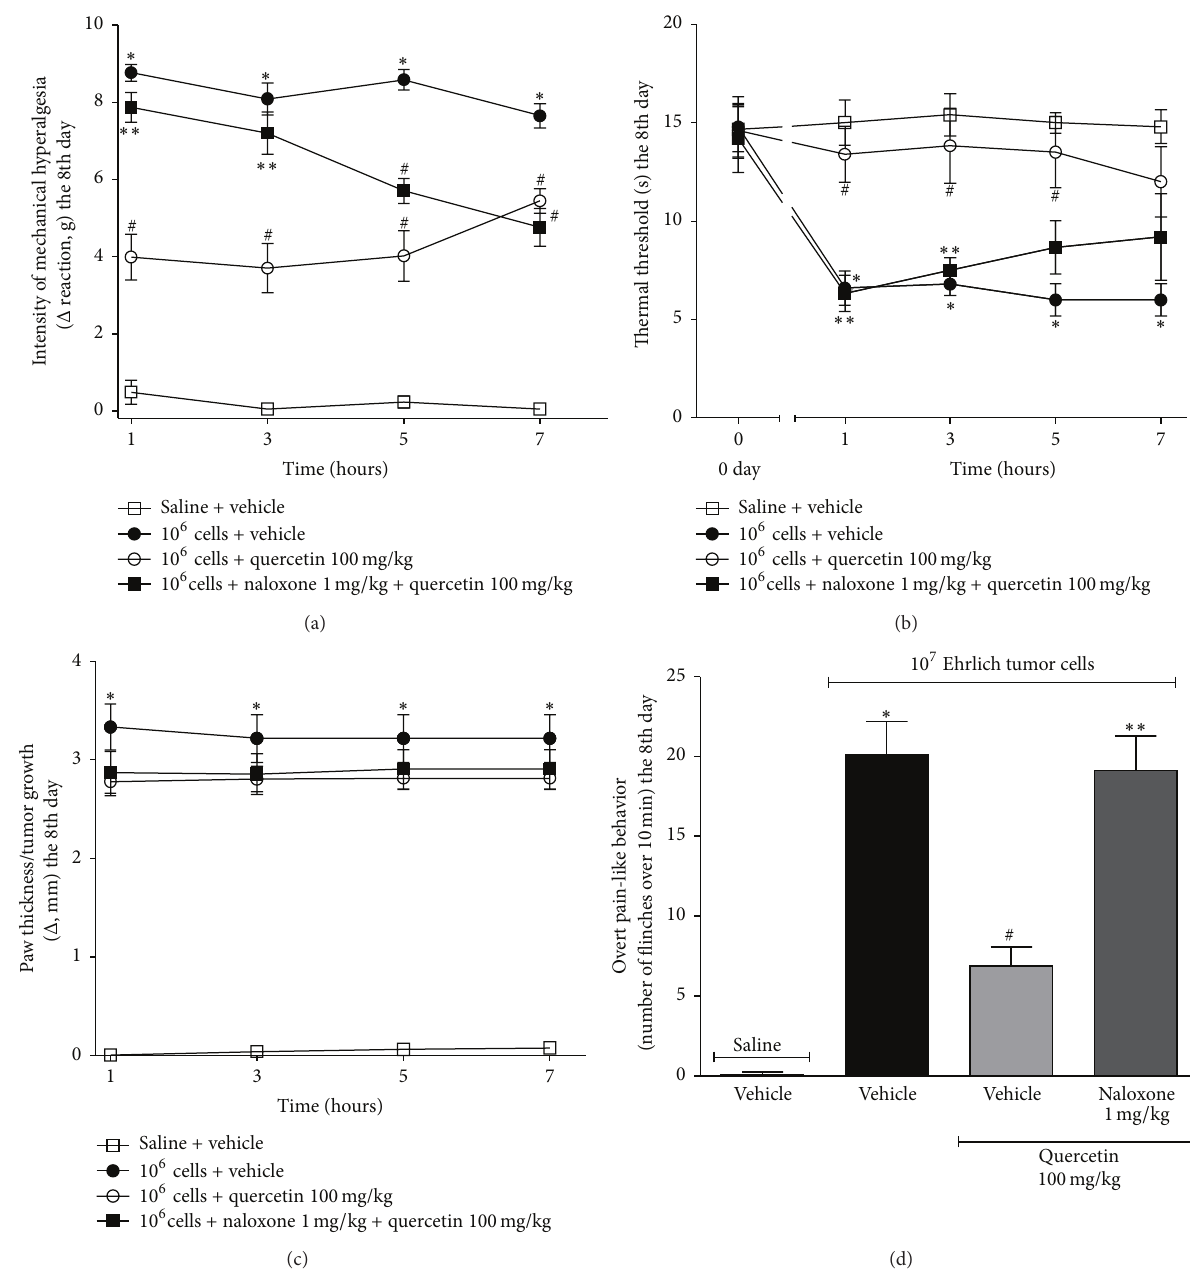
Figure 7: The opioid receptor antagonist, naloxone, inhibits quercetin analgesia in the Ehrlich tumor-induced pain model. Mice were treated with quercetin (100mg/kg, i.p., starting 10min after tumor administration) during 8 days after the injection of Ehrlich tumor cells (1 × 10 6 or 1 × 10 7 cells/25 𝜇 L) or saline and, in the 8th day, one group of mice that received quercetin was also treated with naloxone (1mg/kg i.p. diluted in saline) 1h before the treatment with quercetin. The evaluation of mechanical hyperalgesia (a), thermal hyperalgesia (b), and paw thickness (c) was performed 1, 3, 5, and 7 h after the treatments, and the overt pain-like behavior (d) was evaluated 1h after the treatment. Data are presented as means ± SEM of six mice per group per experiment and representative of two separated experiments: ∗ 𝑝 < 0.05 compared to the saline group, # 𝑝 < 0.05 compared to the tumor group, and ∗∗ 𝑝 < 0.05 compared to the quercetin group. One-way ANOVA followed by Tukey’s